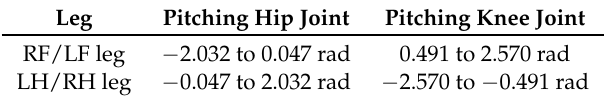
Table 4. The joint position ranges of different joints.